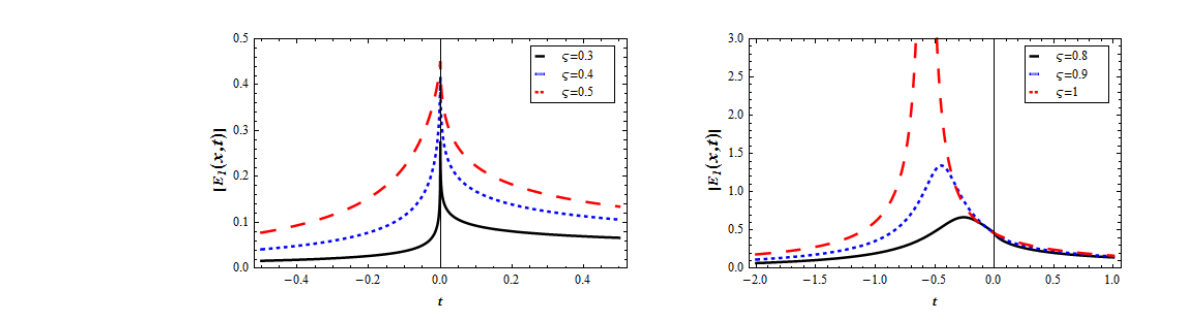
Figure 2. Variation of solution (9) versus t and ς .